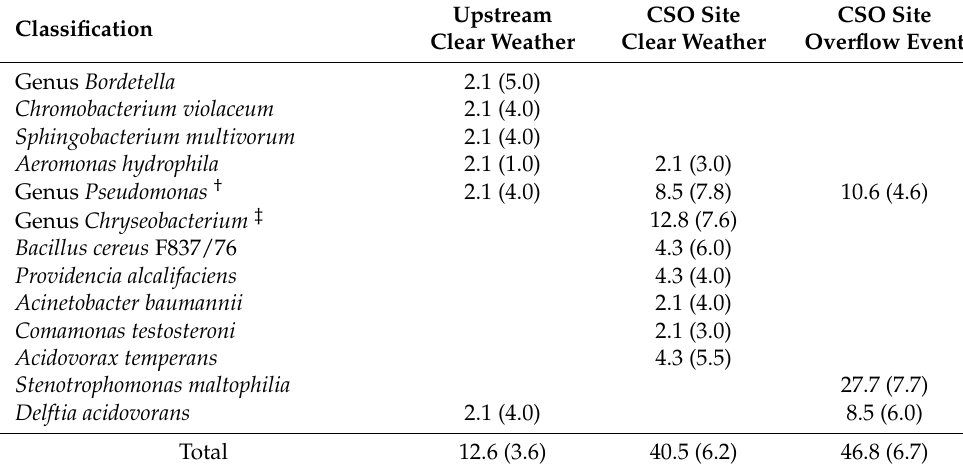
Figure 6. The fraction of isolates at each site that fall within each classification group. Bar color represents the mean MDR for all isolates in the group, with darker bars indicating resistance to a greater number of antibiotics. Within some groups, both pathogenic and non-pathogenic strains were identified. These are presented separately: bars extending left against the white background represent non-pathogenic isolates, while bars extending right against the gray background represent potentially pathogenic isolates. The graph does not include 6 isolates classified as “Other Proteobacteria” (all non-pathogenic). Table 2. Distribution of potentially pathogenic taxa. Data are presented as the % in each classifica- tion/group relative to the total number of potentially pathogenic isolates for each sample. Mean MDR for each group is shown in